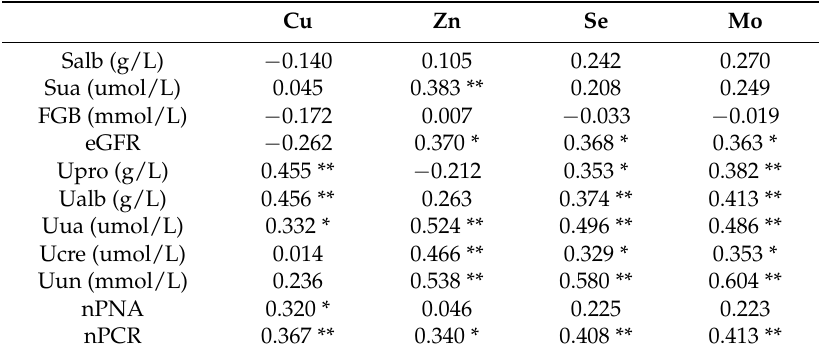
Table 5. Spearman correlation coefficients between study variables and urinary trace element excretions per